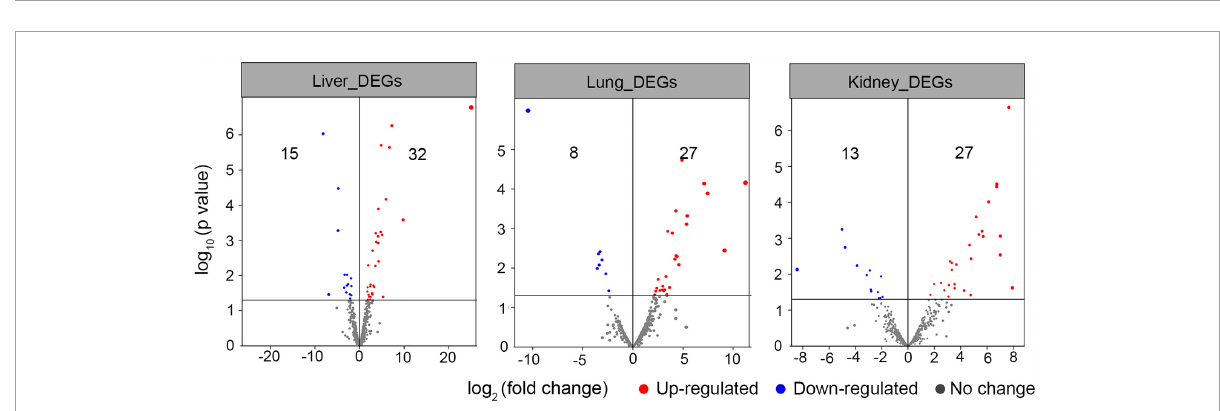
FIGURE5 Volcano plot analysis of differential expressed genes in tissues (i.e., liver, lung, and kidney) of different altitude group of Vulpes . The red dots represent the genes up-regulated in Vulpes in the high altitude group (i.e., Vulpes vulpes montana and Vulpes ferrilata ), the blue dots represent the genes down regulated in Vulpes in the high altitude group, and the gray dots represent the genes that have not changed significantly.